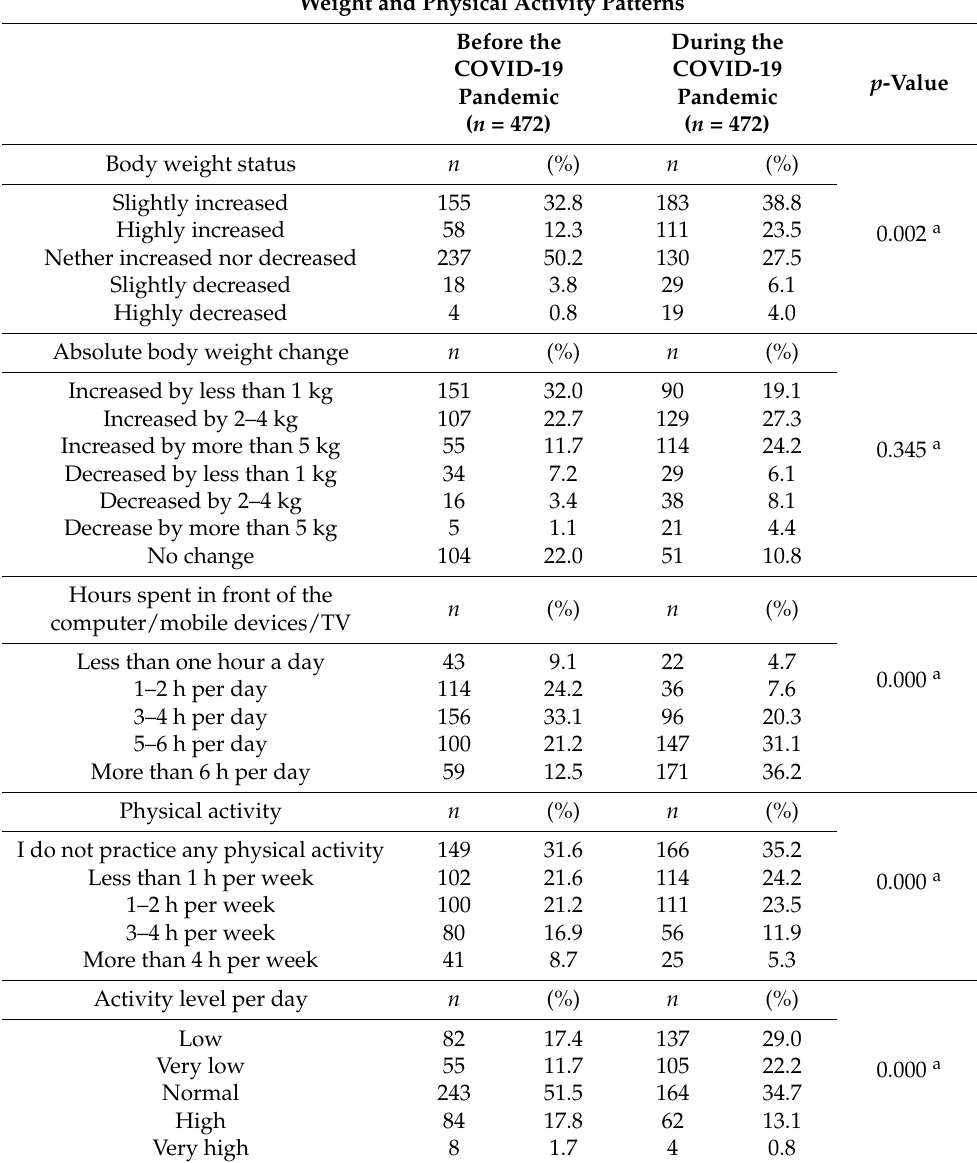
Table 2. Comparison of the body weight, physical activity (PA), and dietary habits before and during the COVID-19 lockdown